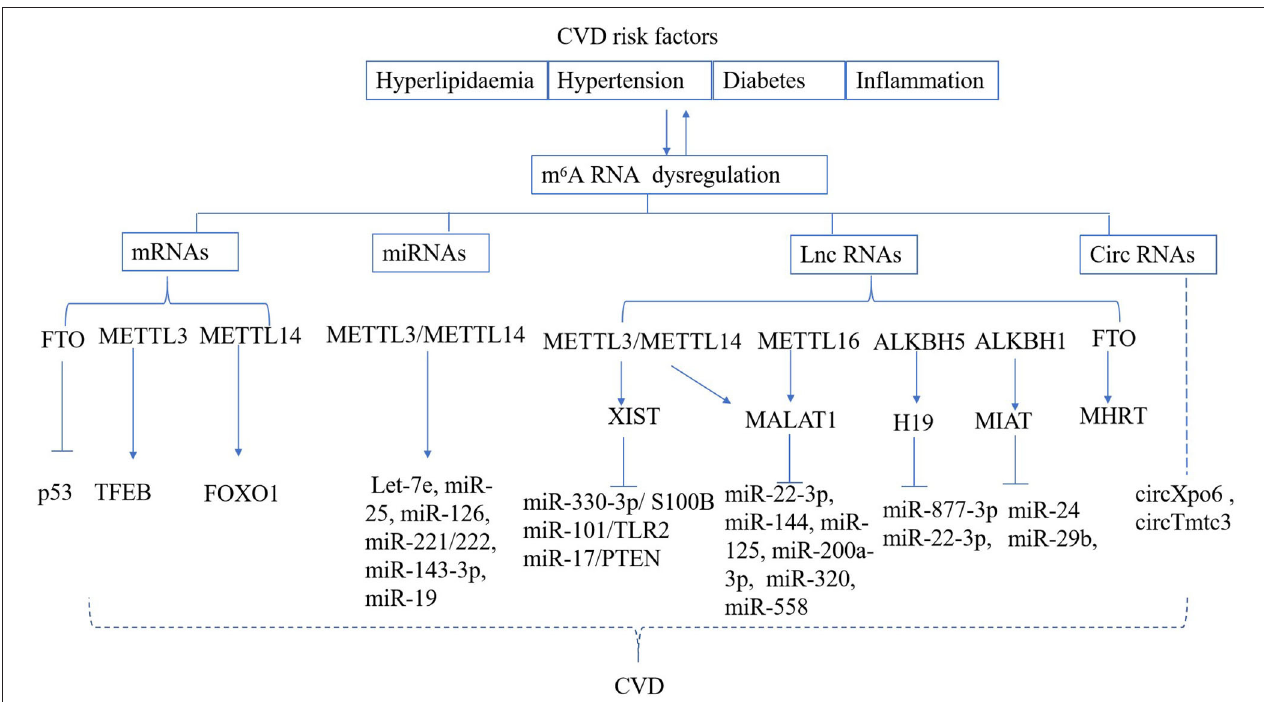
FIGURE 2 | Regulation of m 6 A RNA modification in CVD. CVD risk factors can result in deregulated m 6 A deposition on mRNA, miRNA, lnc RNA, circ RNA, which are known to play a role in the development of cardiac and vascular